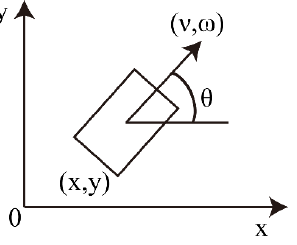
Figure 2. Schematic diagram of the USV kinematic model.